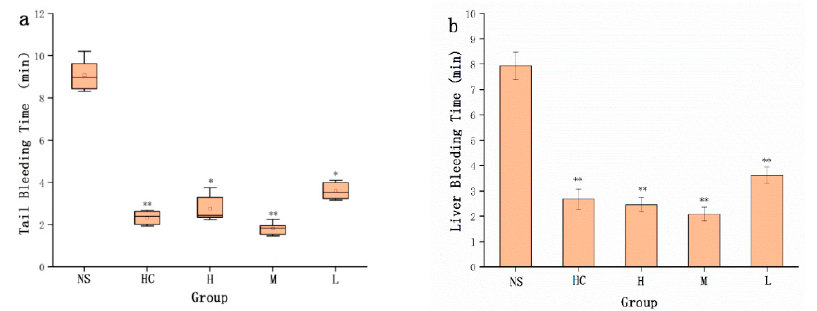
Figure 6. Graphs of haemostatic time in mouse tail amputation and liver scratch models. ( a ) Tail amputation ( n = 8) and ( b ) liver scratch ( n = 8) models treated with normal saline (NS), haemocoagulase (HC), and high (H), medium (M), and low (L) doses of STC ‐ NPs (16.67, 8.33, and 4.17 mg/kg, respectively). ** p < 0.01 and * p < 0.05 compared to the control group ( n = 8).